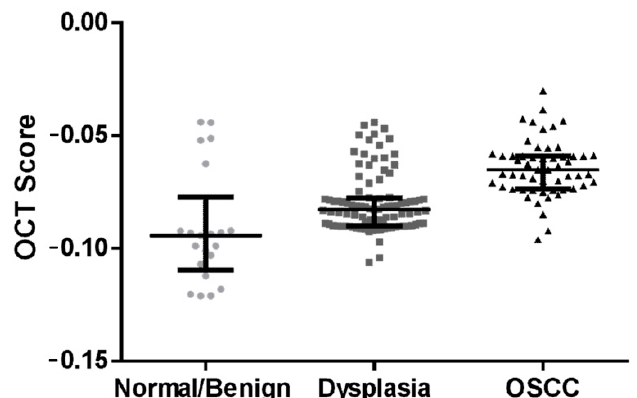
Figure 4. OCT algorithm prediction score distribution between the different patient cohorts. Box and whisker plot depicting the algorithm scores of oral squamous cell carcinoma (OSCC), dysplasia and normal/benign lesions. The score significantly increases ( p < 0.005) as the disease progresses. Graph shows median and inter-quartile range.